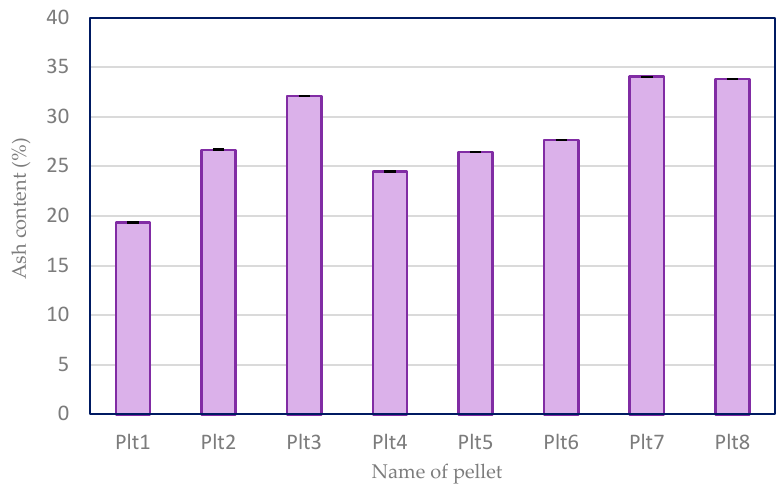
Figure 10. The ash content of the eight types of pellets.